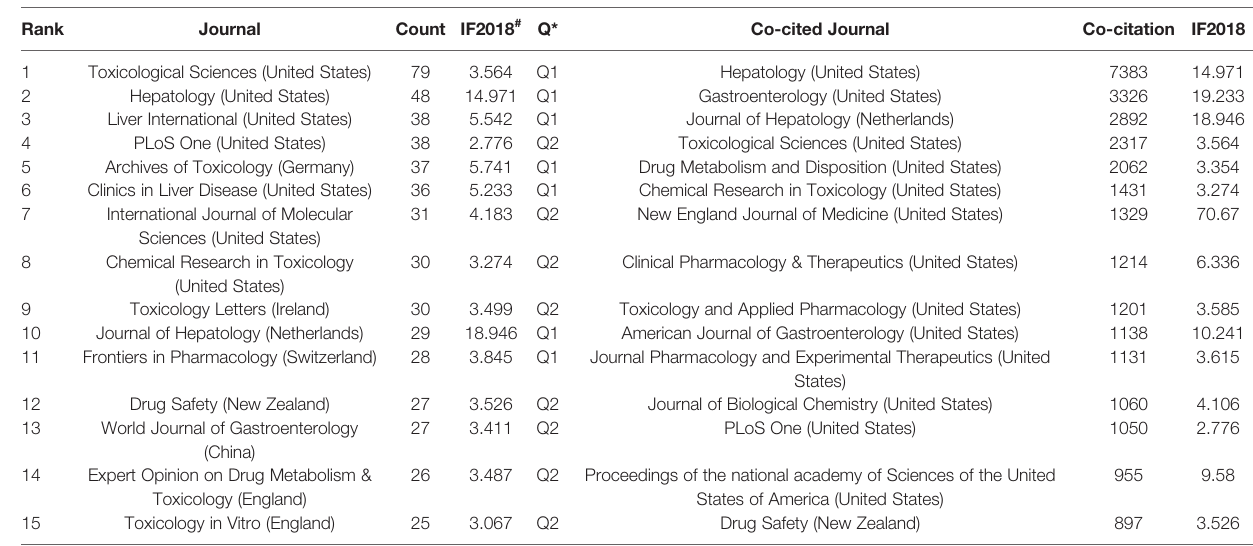
TABLE 2 | The top 10 journals and co-cited journals of DILI